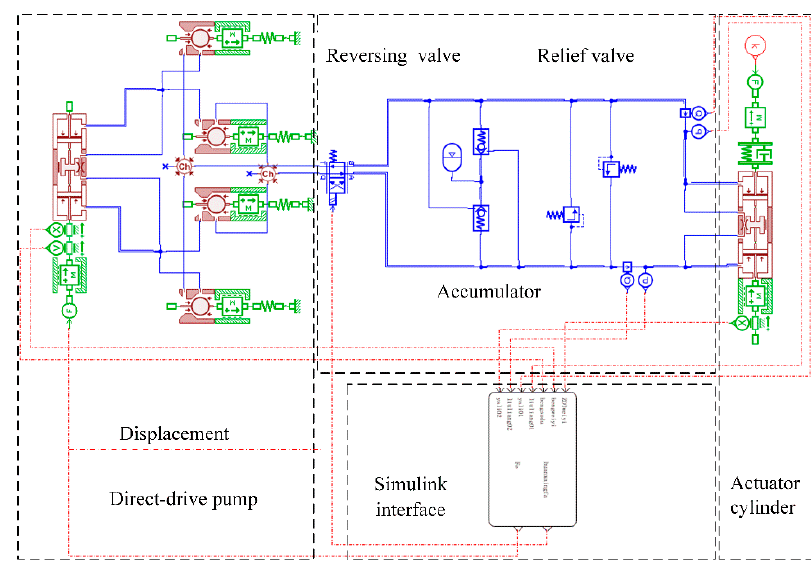
Figure 3. Simulation model of the DEHAS in AMESim.